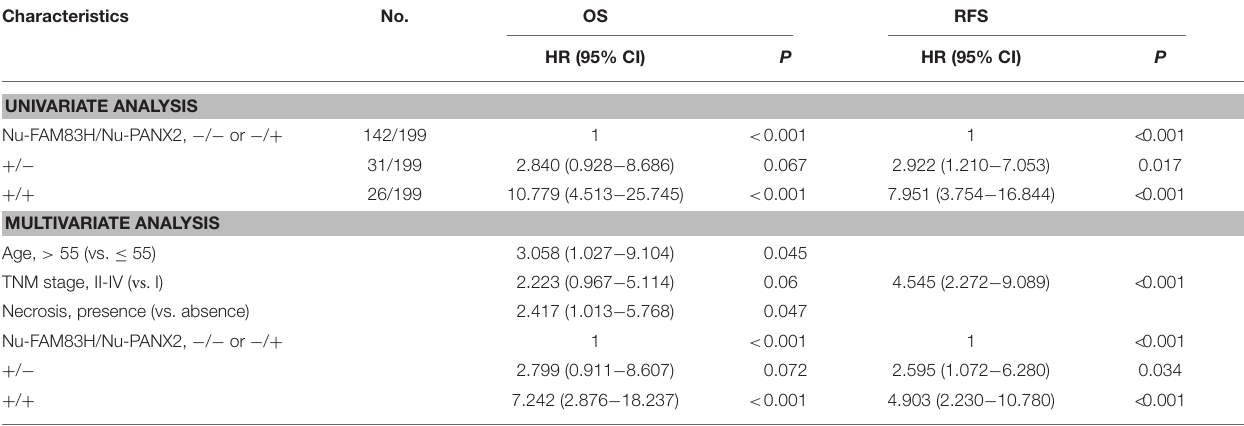
TABLE 5 | Univariate and multivariate analysis of the overall survival and relapse-free survival according to the co-expression patterns of nuclear FAM83H and nuclear PANX2 expression. Characteristics No.